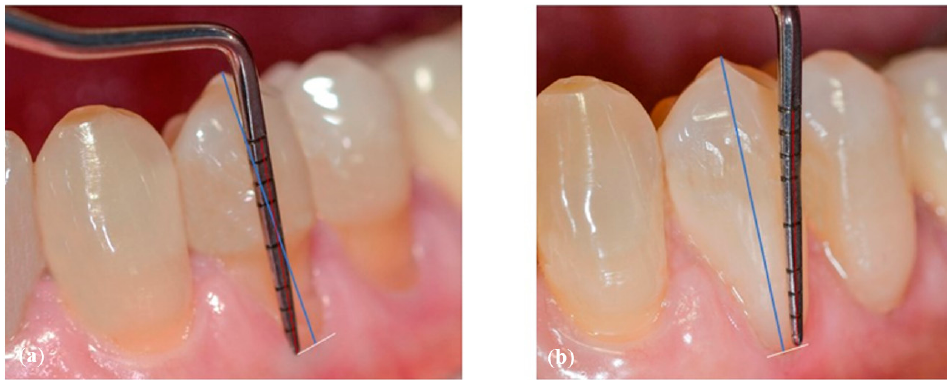
Figure 2. Crown Length (CL) measurement ( a ) at baseline (t0) and ( b ) at reevaluation (t1).